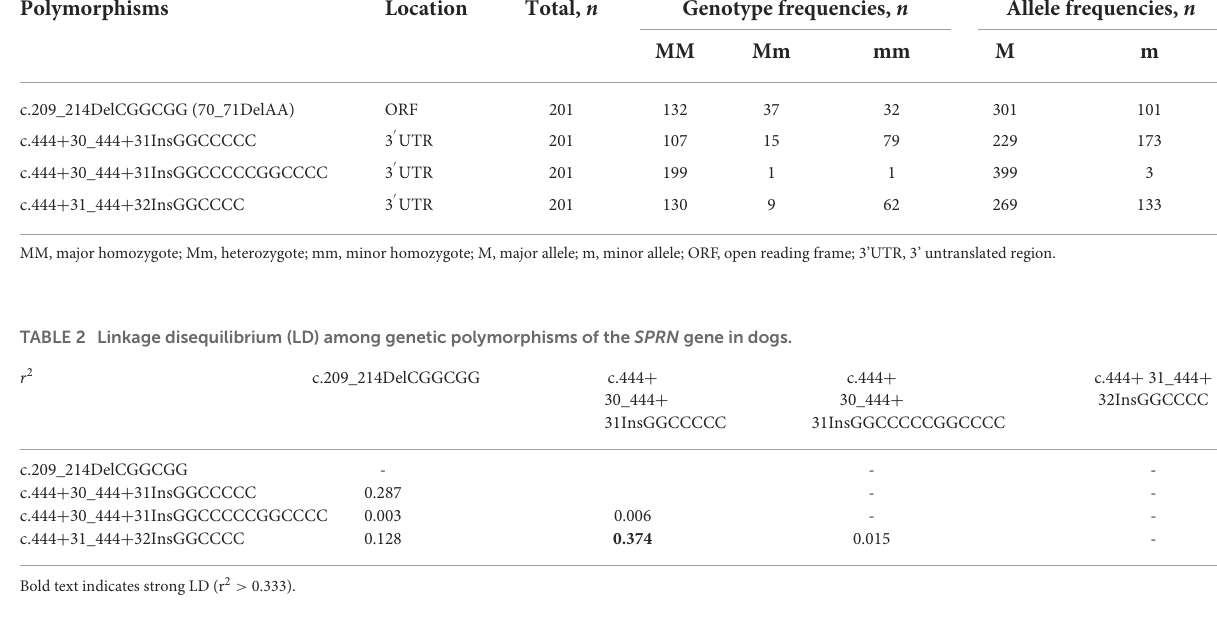
TABLE 1 Genotype and allele frequencies of shadow of prion protein gene ( SPRN ) polymorphisms in 201 dogs. Polymorphisms